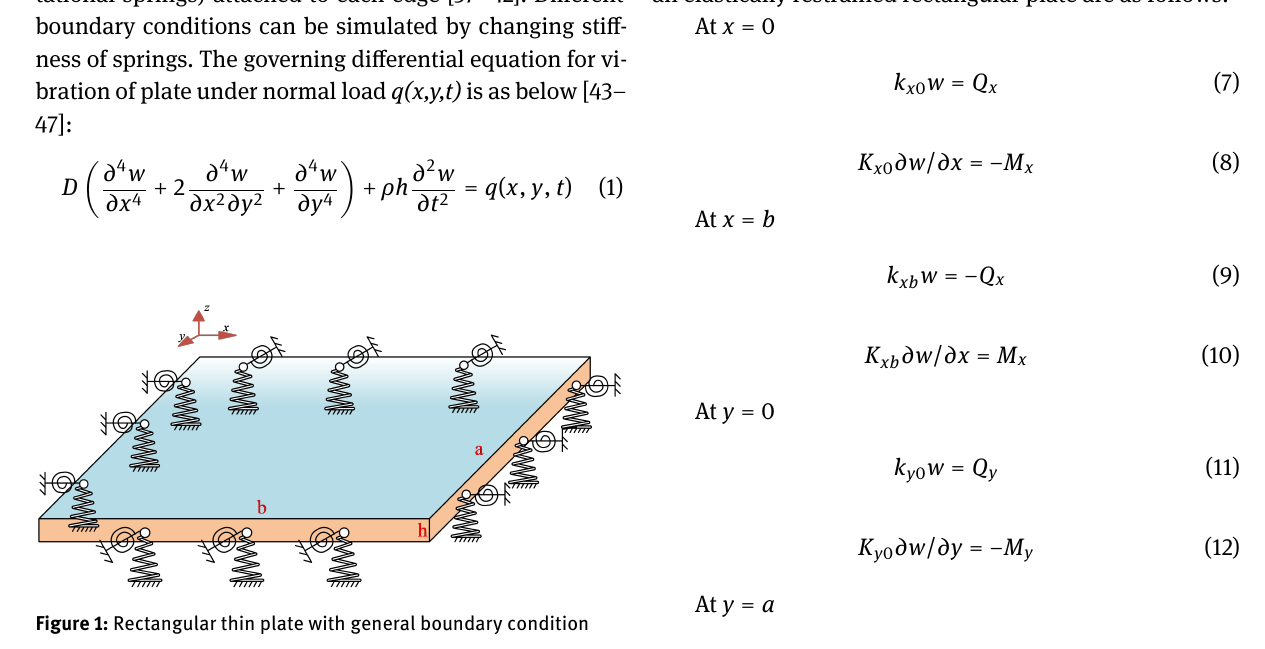
When q ( x , y , t ) = 0, the governing differential equa- tion is about free vibration of plate and can be simplified as: